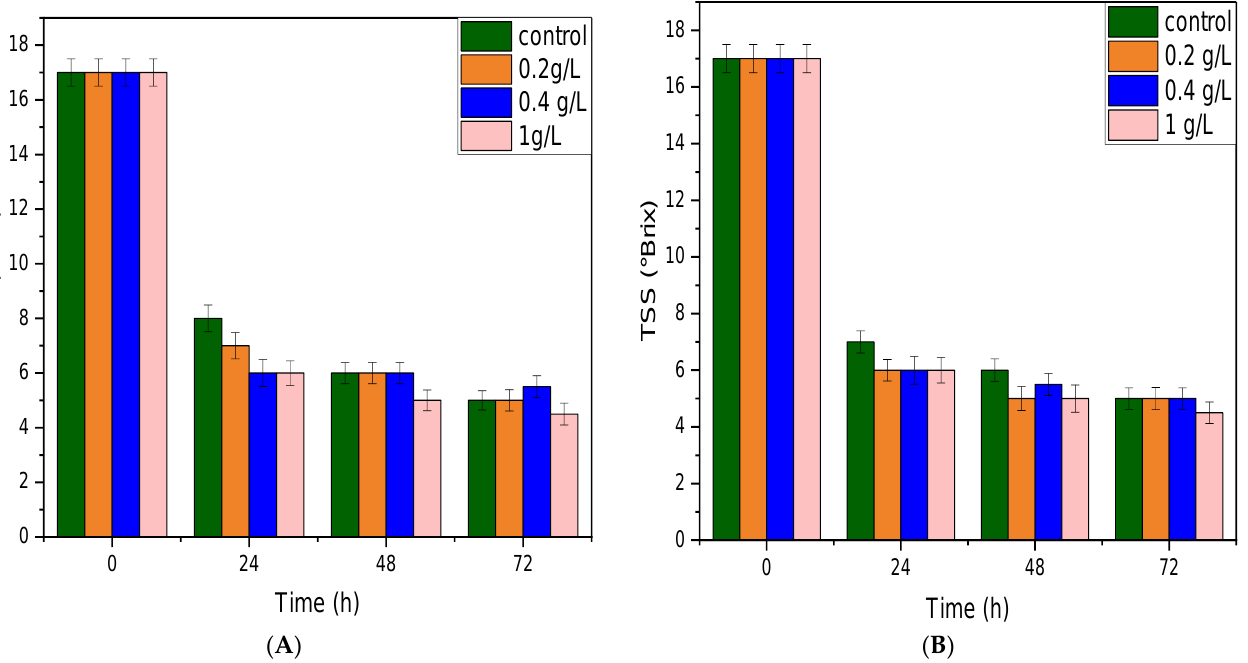
Figure 5. Assessment of total soluble solids (TSS) during anaerobic fermentation: ( A ) effect of yeast extract and ( B ) effect of NH 4 Cl.